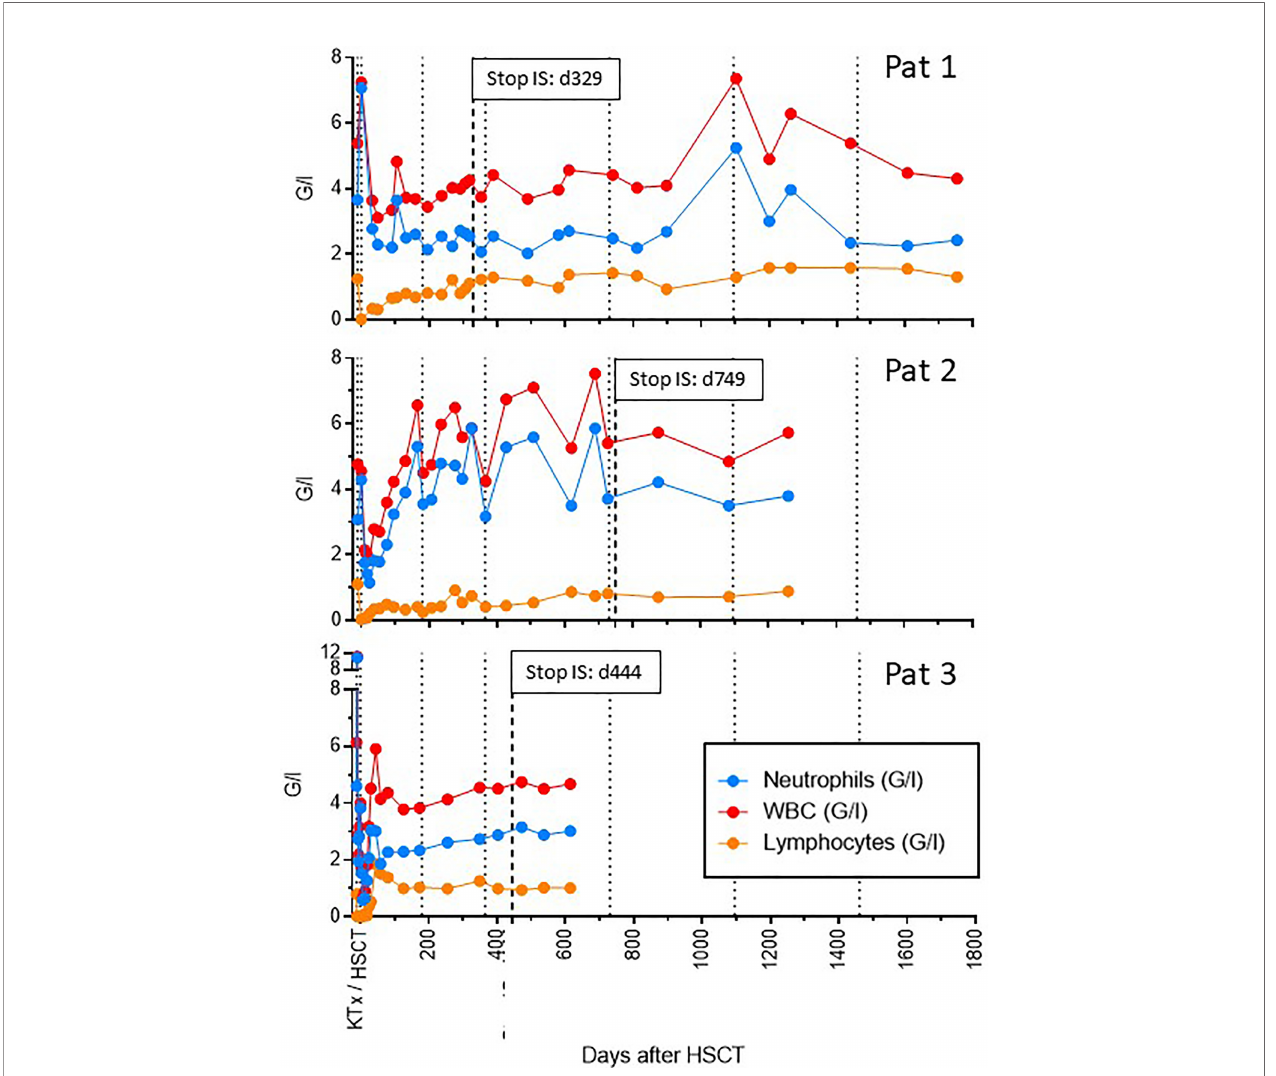
FIGURE 5 | Synopsis of hematological parameters over time. The number of total leukocytes, neutrophils and lymphocytes is shown over time for all three recipients. Dotted lines indicate time intervals of 6 and 12 months post-transplant and yearly thereafter. The hatched line indicates the time point of stop of all immunosuppressive treatment (IS). Profound lymphopenia around the time of transplantation was seen in all three recipients. However, only patient 3 also experienced transient neutropenia, which resolved by 4 weeks